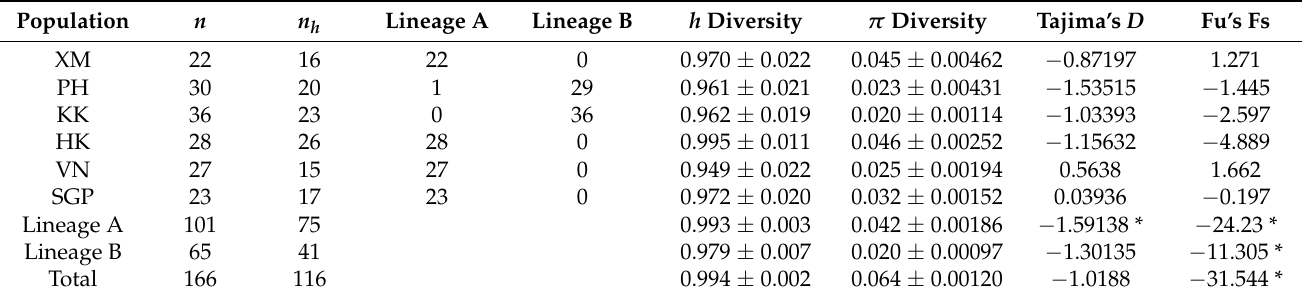
Table 1. Codes of sampling sites, sample sizes ( n ), number of haplotypes ( n h ), gene diversity ( h ), nucleotide diversity ( π ), Tajima’s D , and Fu’s Fs statistics for 6 populations of Portunus pelagicus in Southeast Asia.